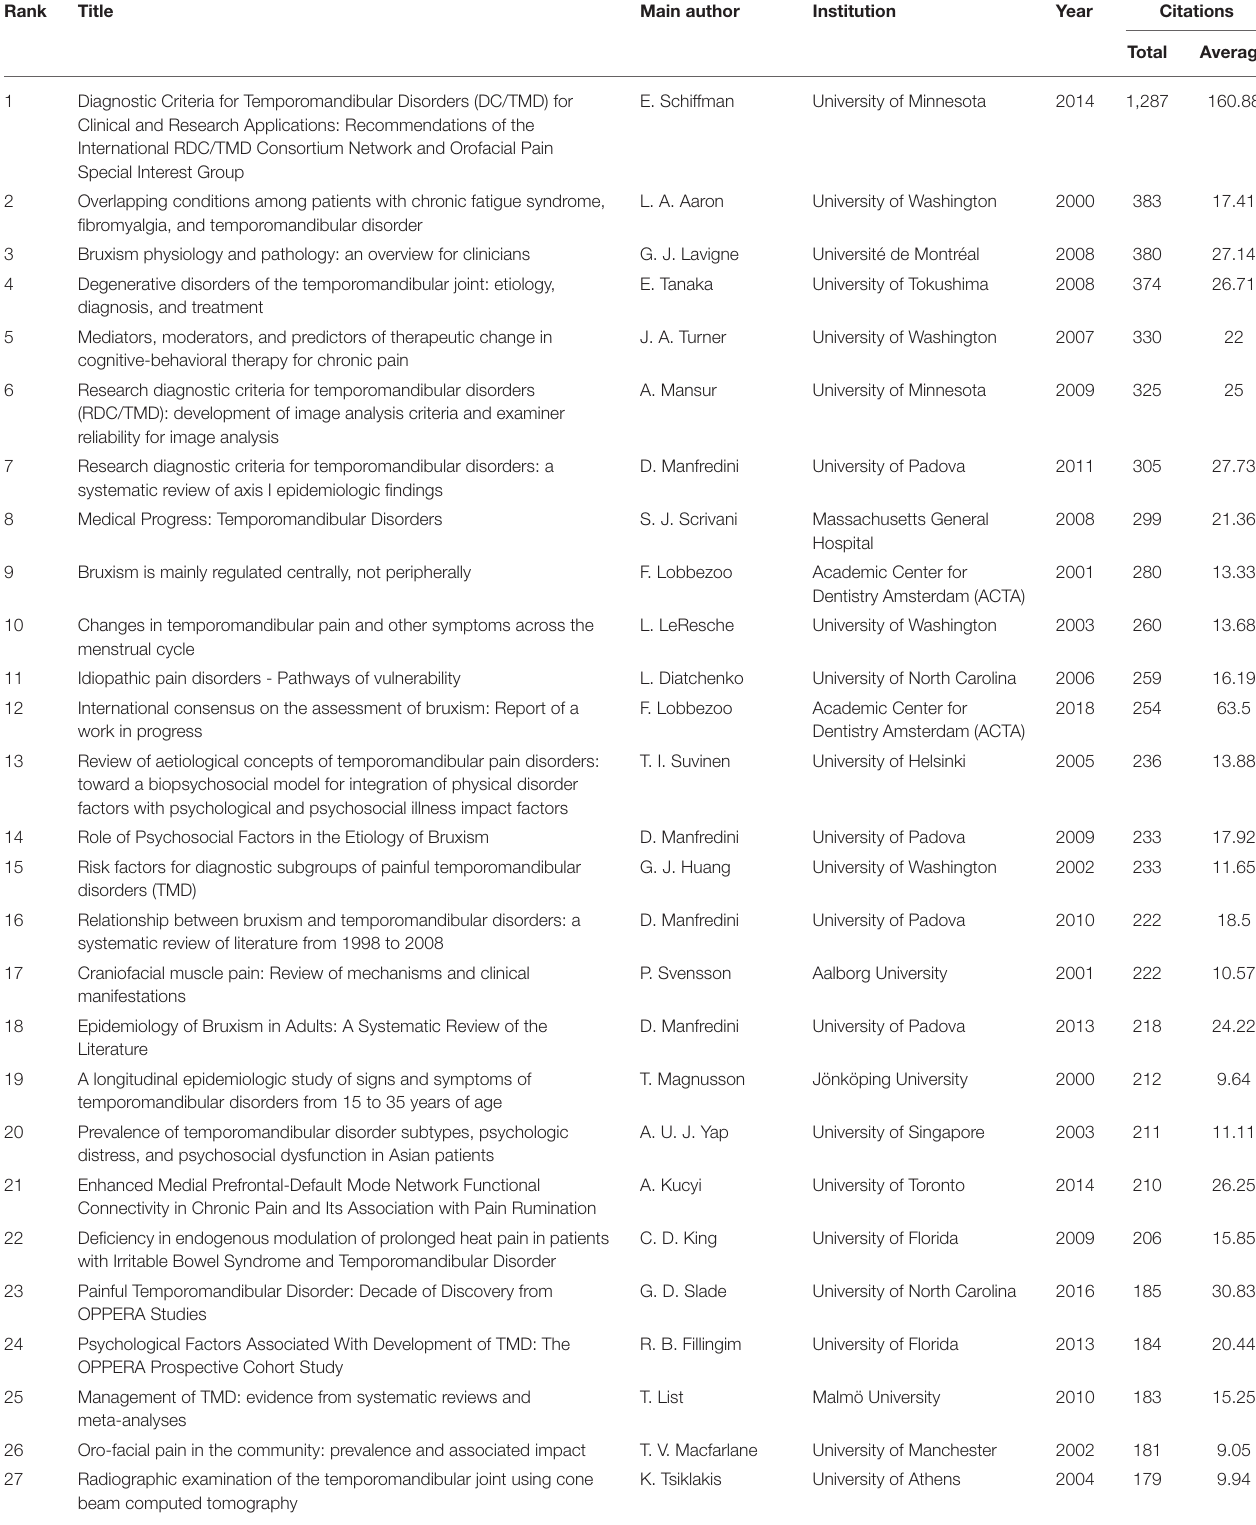
TABLE 1 | The top 100 cited studies in the field of temporomandibular disorders from year 2000 to